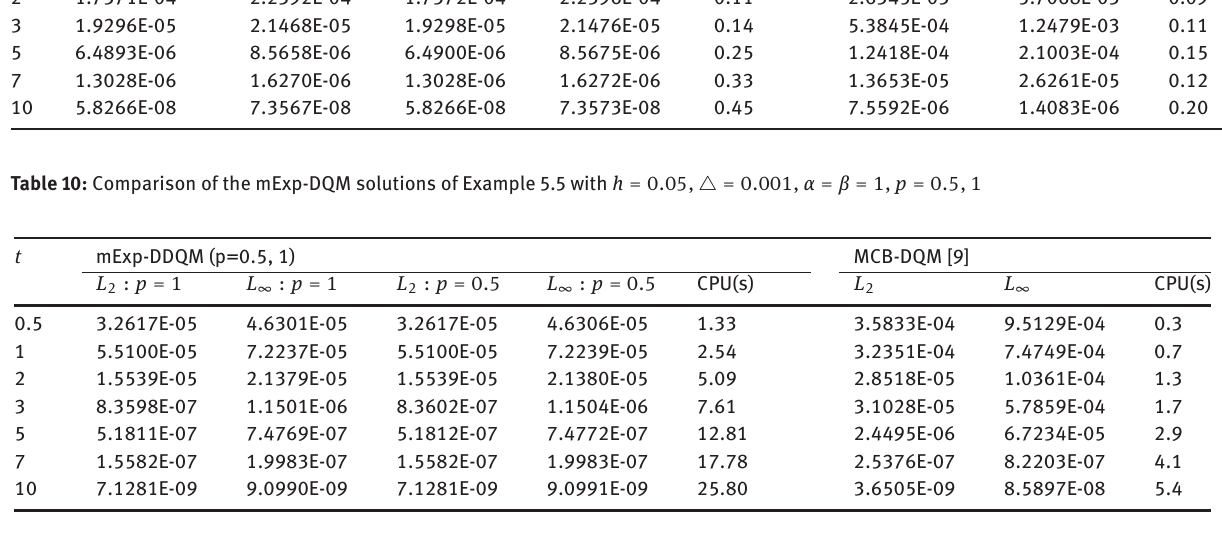
Table 11: Comparison of the mExp-DQM solutions of Example 5.6 with α = β = 1, (cid:2) t = 0.001, p = 1 and h =